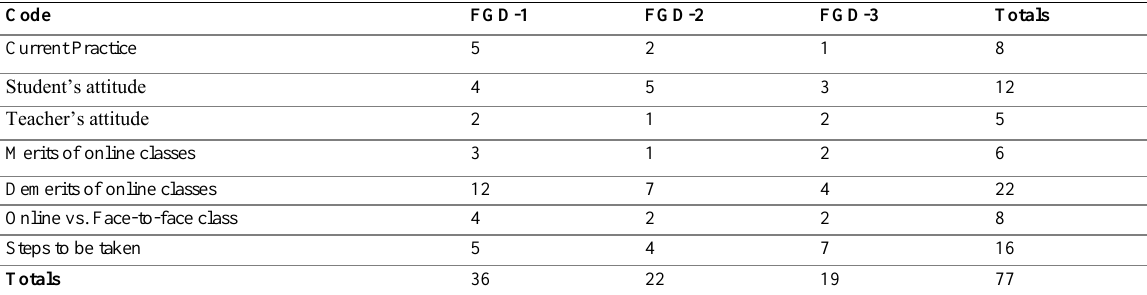
Table 5: Code-document table for FGD